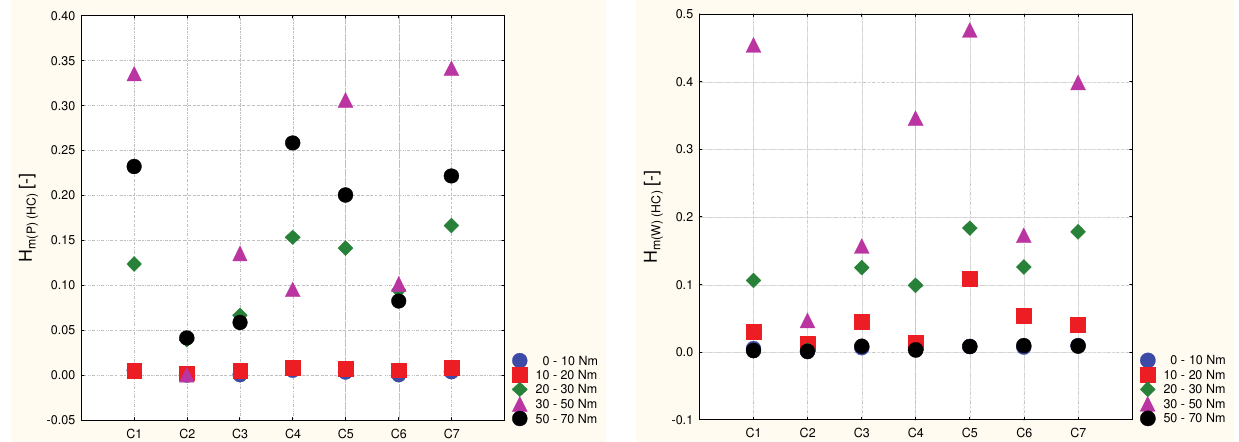
Fig. 2. Values of the information capacity index H m for HC and the transient state at n = 1100 r/min and a change of load from T tq = 0 Nm to T tq = 70 Nm: P – delayed angle of injection advance; W – accelerated angle of injection advance; C 1 – C 7 – combinations of illustrative